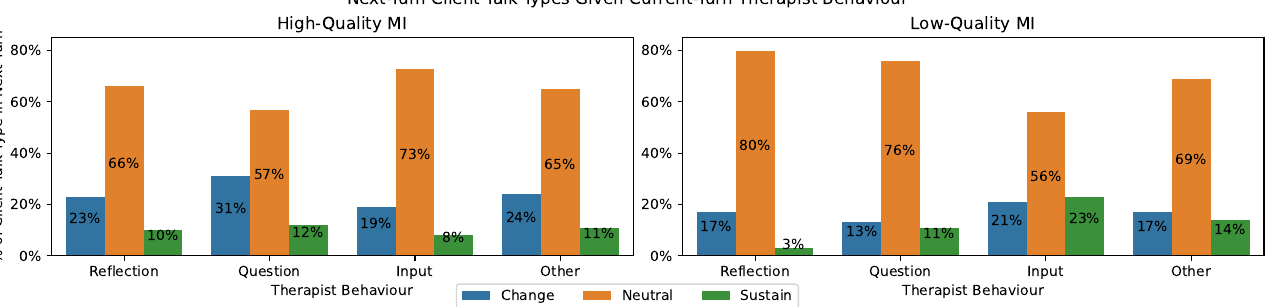
Figure 3. Distribution of next-turn client talk types given different therapist behaviours in the current turn.